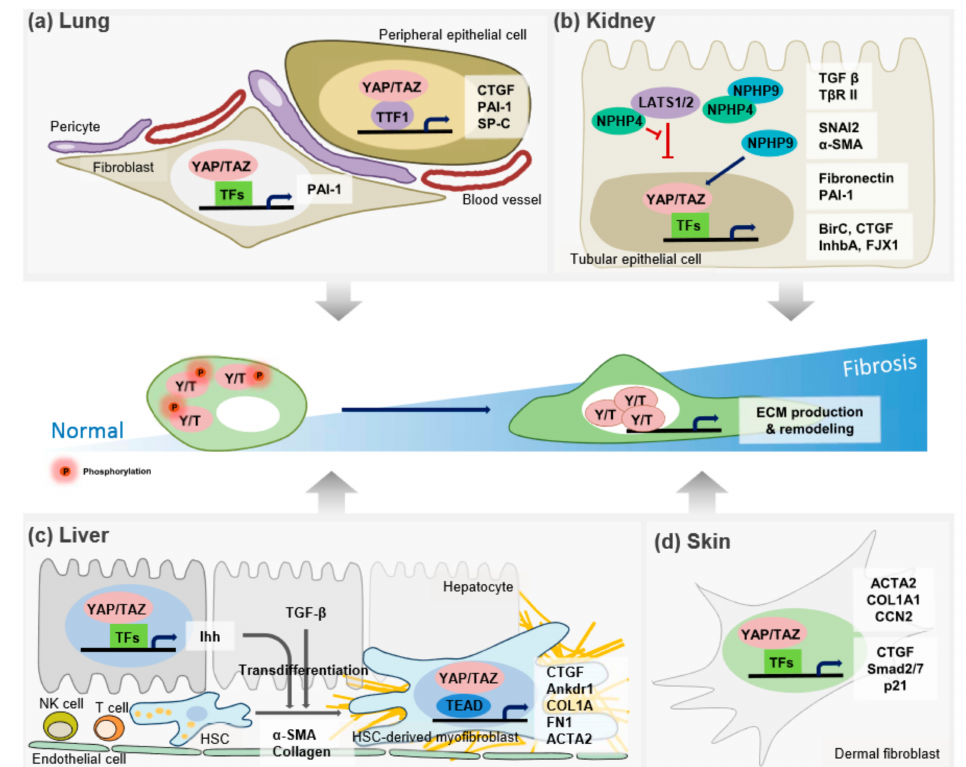
Figure 1. The role of the Hippo pathway in the pathogenesis of tissue fibrosis. In normal cells, YAP / TAZ are phosphorylated and localized in the cytoplasm, leading to their inactivation. However, in many pathological situations, YAP / TAZ localize to the nucleus, and up-regulate their target genes to remodel the ECM. This action leads to tissue fibrosis. ( a ) In respiratory epithelial cells, binding YAP / TAZ with TTF-1 synergistically activates the expression of target genes, including SP-C, CTGF, and PAI-1. Also, active fibroblasts promote matrix synthesis via YAP / TAZ that are critical to the induction of profibrotic genes, such as CTGF and PAI-1, in the development of lung fibrosis. ( b ) NPHP4, by interacting with LATS1 / 2, promotes YAP / TAZ transcriptional activity. In contrast, NPHP9, another NPH proteins (NPHPs), directly interacts with YAP / TAZ and induces its nuclear localization to regulate a subset of target genes involved in renal fibrosis. ( c ) YAP / TAZ-mediated Indian hedgehog (Ihh) gene induction, which increases transcriptional reprogramming by modulating profibrotic gene expression in HSCs. In response to Ihh and TGF- β , HSCs transdi ff erentiate into the ECM-producing myofibroblasts. ( d ) YAP / TAZ are mainly localized with the nucleus, resulting in the profibrotic gene expression in dermal fibrolasts. See text for further details. The red spheres indicate the phosphorylation of YAP / TAZ by